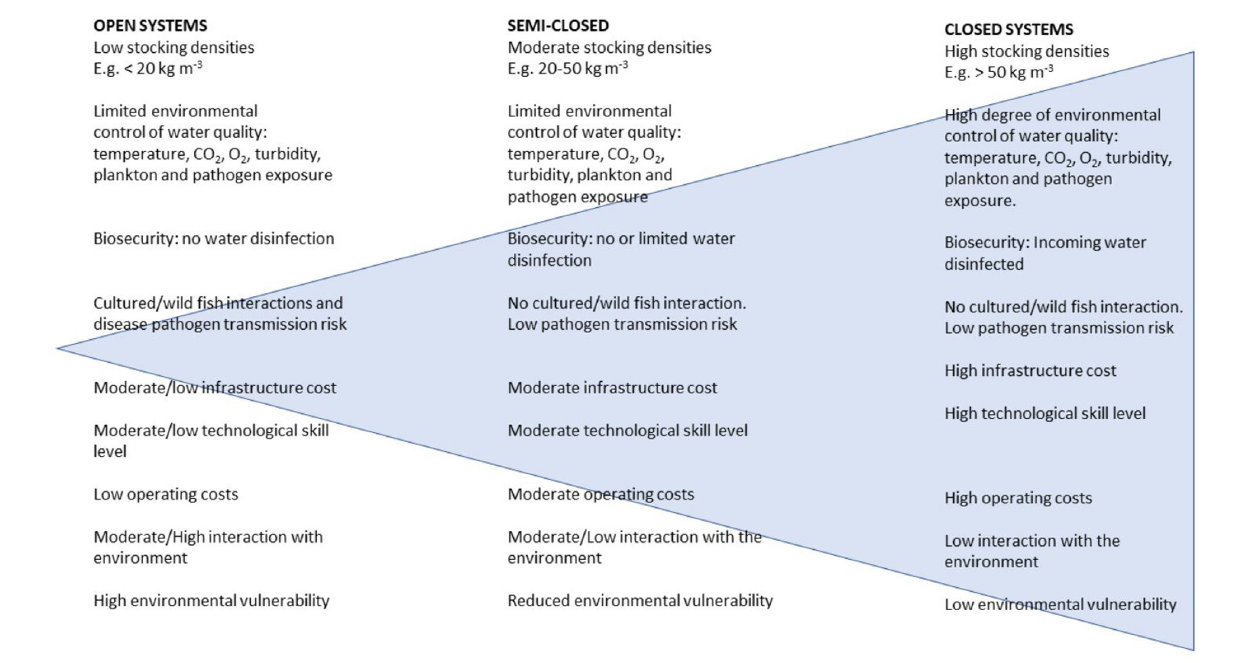
FIGURE 1 | Qualitative comparison of the characteristics of open, semi-closed, and closed aquaculture systems with the qualitative range of complexity indicated by the blue triangle (used with permission, M. Powell).